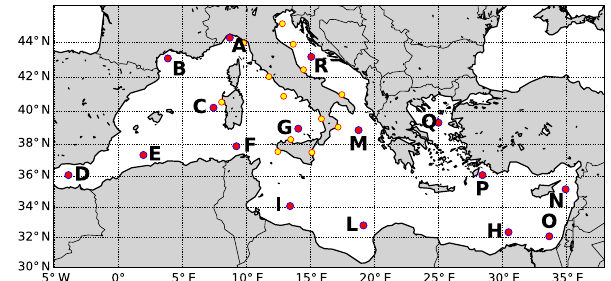
Figure 2. Hindcast control grid points (red circle) and RON buoys as reference points (yellow